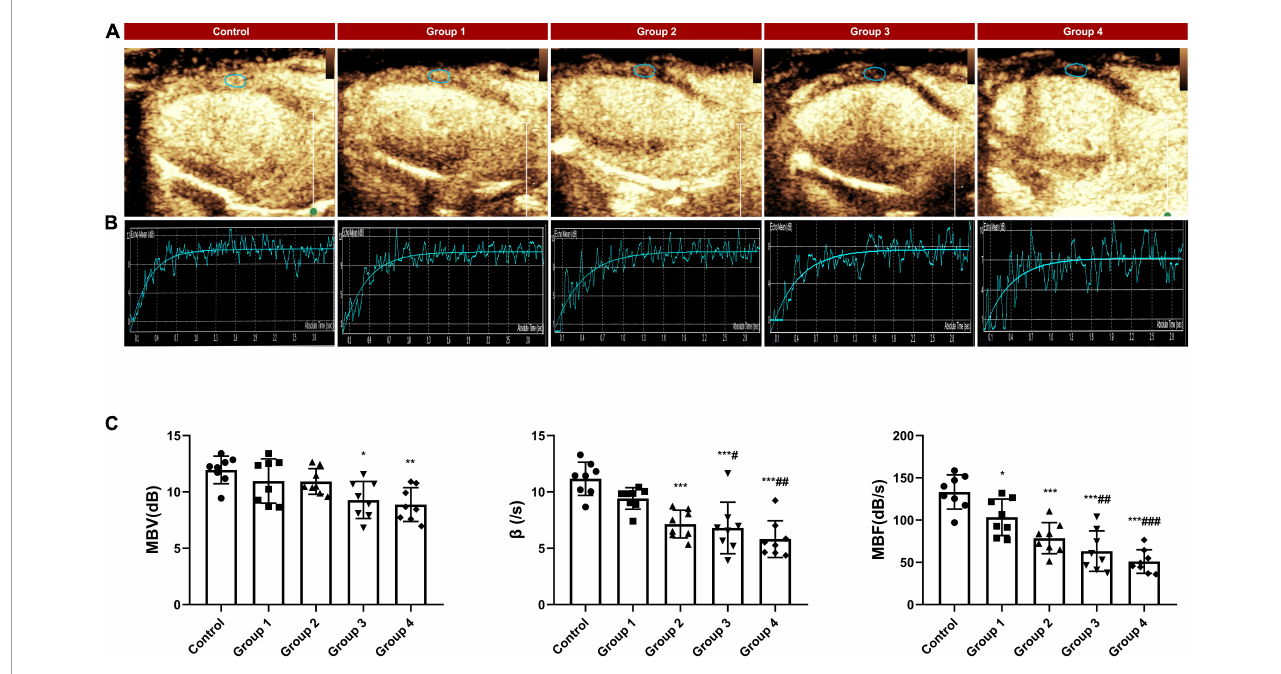
FIGURE3 MCE assessed myocardial perfusion during DOX-induced cardiotoxicity development. (A) Representative MCE-based myocardial perfusion images of MCE in the five groups; (B) Representative time–intensity curves in the five groups, MBV = 11.31 dB, β = 12.56/s and MBF = 142.06 dB/s in control, MBV = 10.24 dB, β = 10.43/s and MBF = 106.80 dB/s in group 1, MBV = 10.63 dB, β = 7.86/s and MBF = 83.55 dB/s in group 2; MBV = 8.97 dB, β = 6.49/s and MBF = 58.21 dB/s in group 3; MBV = 7.24, β = 5.63/s and MBF = 40.76 dB/s in group 4; (C) The difference in MBV, wash in slope and MBF